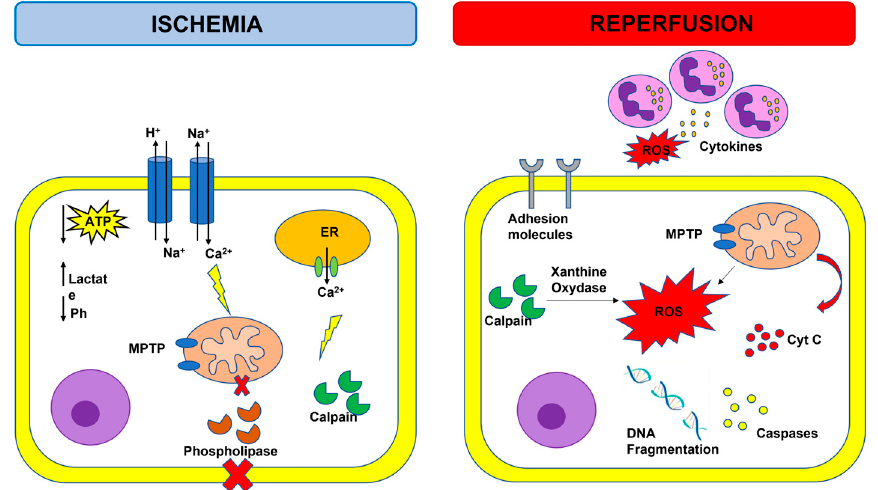
Figure 1. Overview of ischemia-reperfusion injury. Adenosine triphosphate (ATP); cytochrome C (cyt C); endoplasmic reticulum (ER); mitochondrial permeability transition pore (MPTP); reactive oxygen species (ROS); purple cells: neutrophils.